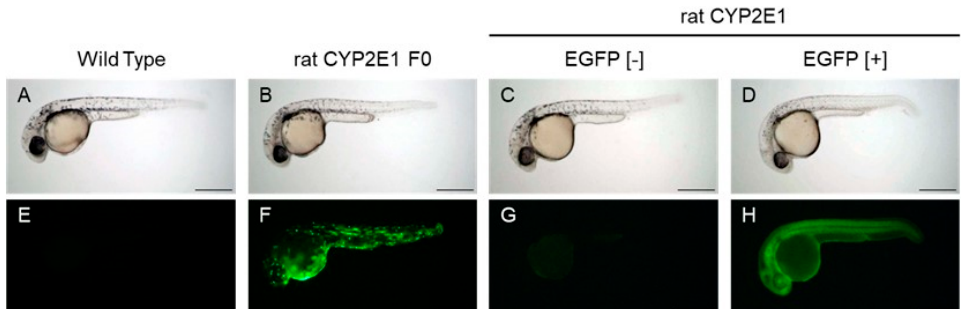
Figure 1. EGFP expression in embryonic zebrafish expressing EGFP and rat CYP2E1. ( A – D ) are bright field images of 32 hpf embryos showing EGFP fluorescence in the lower row ( E – H ). ( A , E ): wild-type embryo. ( B , F ): pT2A plasmid-injected embryo (rat CYP2E1 F0). ( C , D , G , H ): transgenic embryo (F2) that was obtained via incross mating between F1 [+/ − ] adult fish. ( C , G ): EGFP-negative embryo (EGFP [ − ]). ( D , H ): Strongly fluorescent embryos (EGFP [+]). Bar indicates 200 µm.